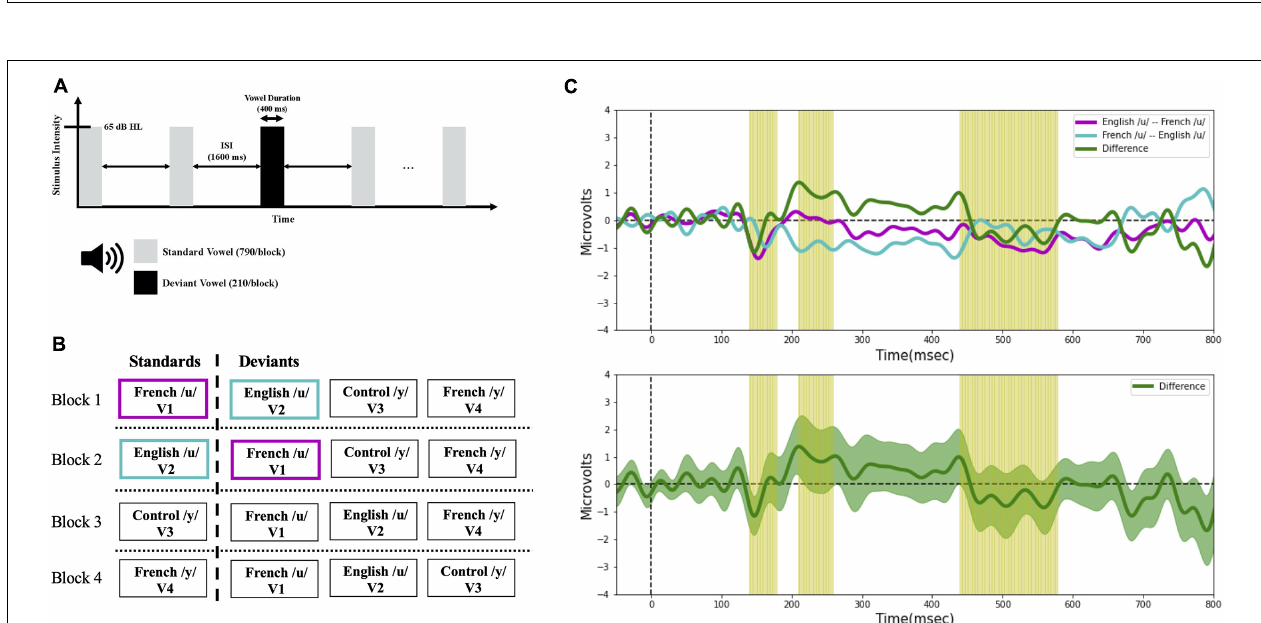
FIGURE 3 | (A) Timeline of the stimulus presentation in the oddball task. (B) Schematic of the experimental design, and (C) example MMN waveforms. Four experimental blocks were presented to each participant in a randomized order. The color coding in panel (B,C) illustrates the ERP averaging technique applied in the current study. For example, to characterize the detection of V1 among V2 (i.e., V2 → V1 direction), the MMN (purple line) was calculated by subtracting the ERPs to French /u/ (V1) as deviant measured in a block where the English /u/ (V2) was the standard, from the ERPs to French /u/ (V1) as standard in a separate block. Conversely, to characterize the detection of V2 among V1 (i.e., V1 → V2 direction), the MMN (turquoise line) was calculated by subtracting the ERPs to English /u/ (V2) as deviant measured in a block where the French /u/ (V1) was the standard, from the ERPs to English /u/ (V2) as standard in a separate block. In this way, we obtained an average ERP for the standards and for the deviants that was unaffected by the physical characteristics of the stimuli, and only the oddball effect was present when comparing the standard and deviant waveforms. The same averaging technique was applied with the rest of the contrasts. To test for directional asymmetries in the MMN, difference waves (green line) were then computed by subtracting the MMN waveform for the two opposite stimulus orders (e.g., V2 → V1 vs. V1 → V2); this is shown in the bottom panel of 3C with the green shaded region representing the standard error.